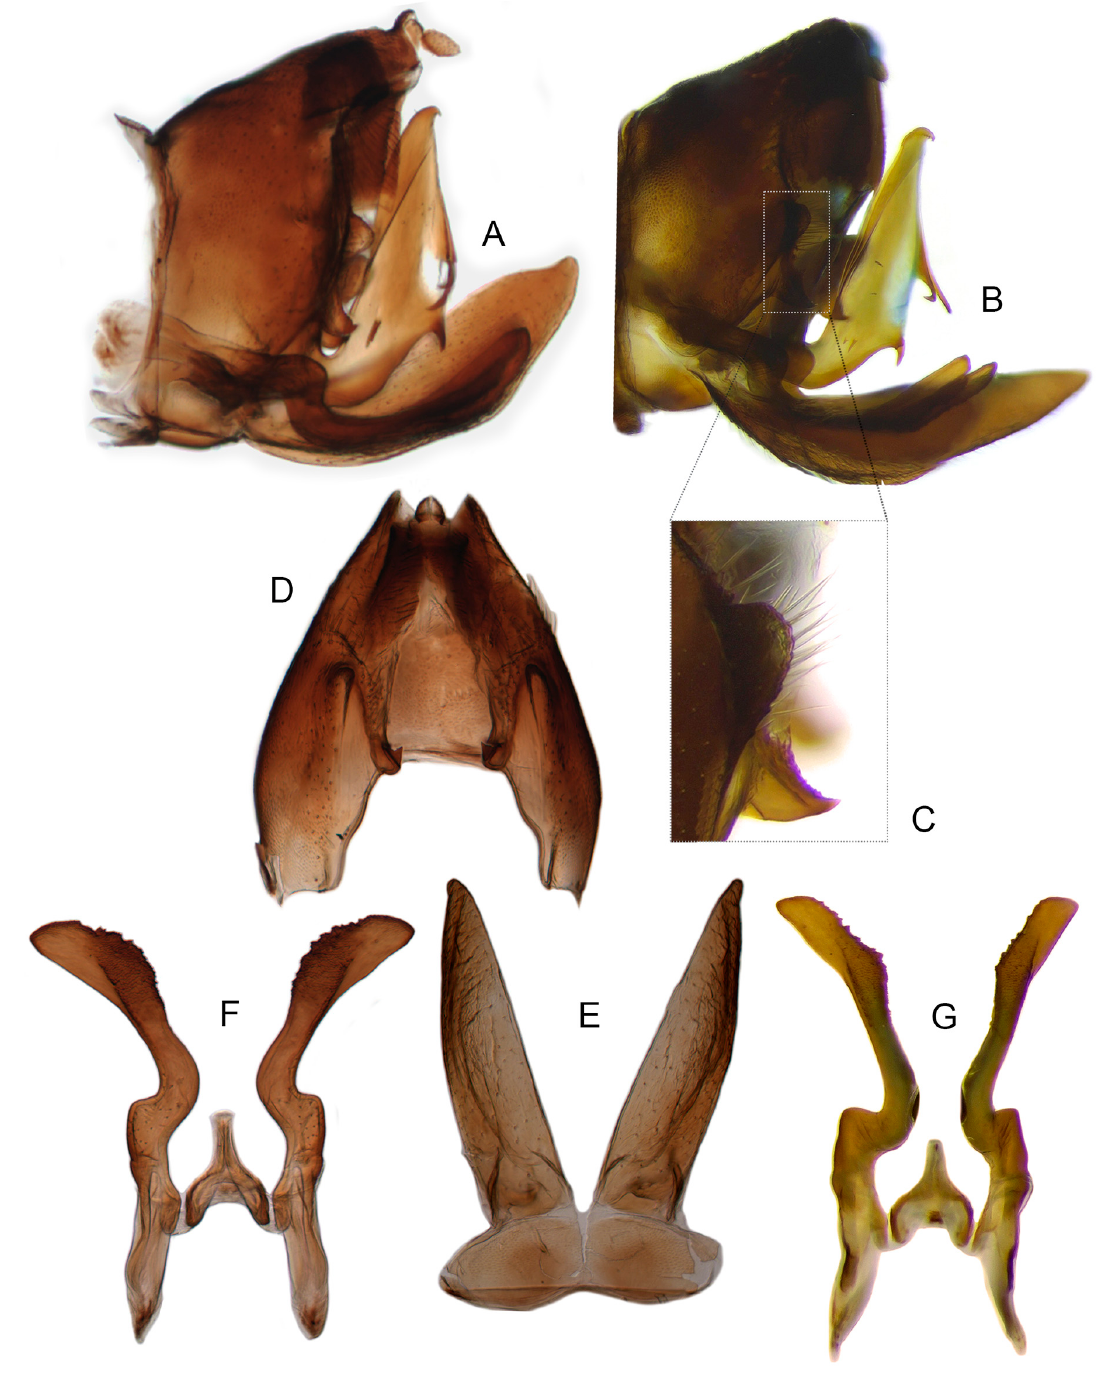
Figure 6. ( A – G ) Planaphrodes nigricans . ( A , B ) pygofer, lateral view. ( C ) caudal margin processes of pygofer. ( D ) genital capsule, ventral view. ( E ) subgenital plates, ventral view. ( F , G ) styles and connective, ventral view ( A , D – F ) from China, Heilongjiang Province; ( B , C , G from Korea, Jindo JN).